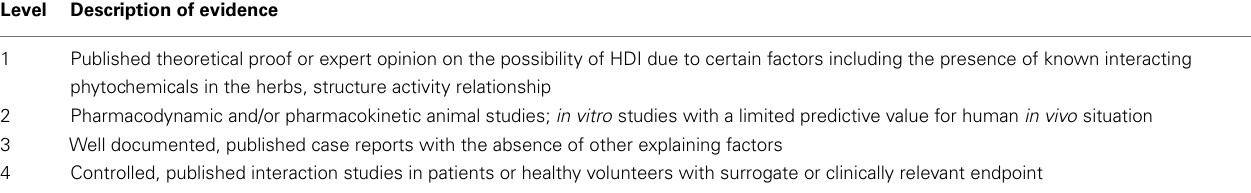
Table 2 | Quality of HDI evidence for clinical risk